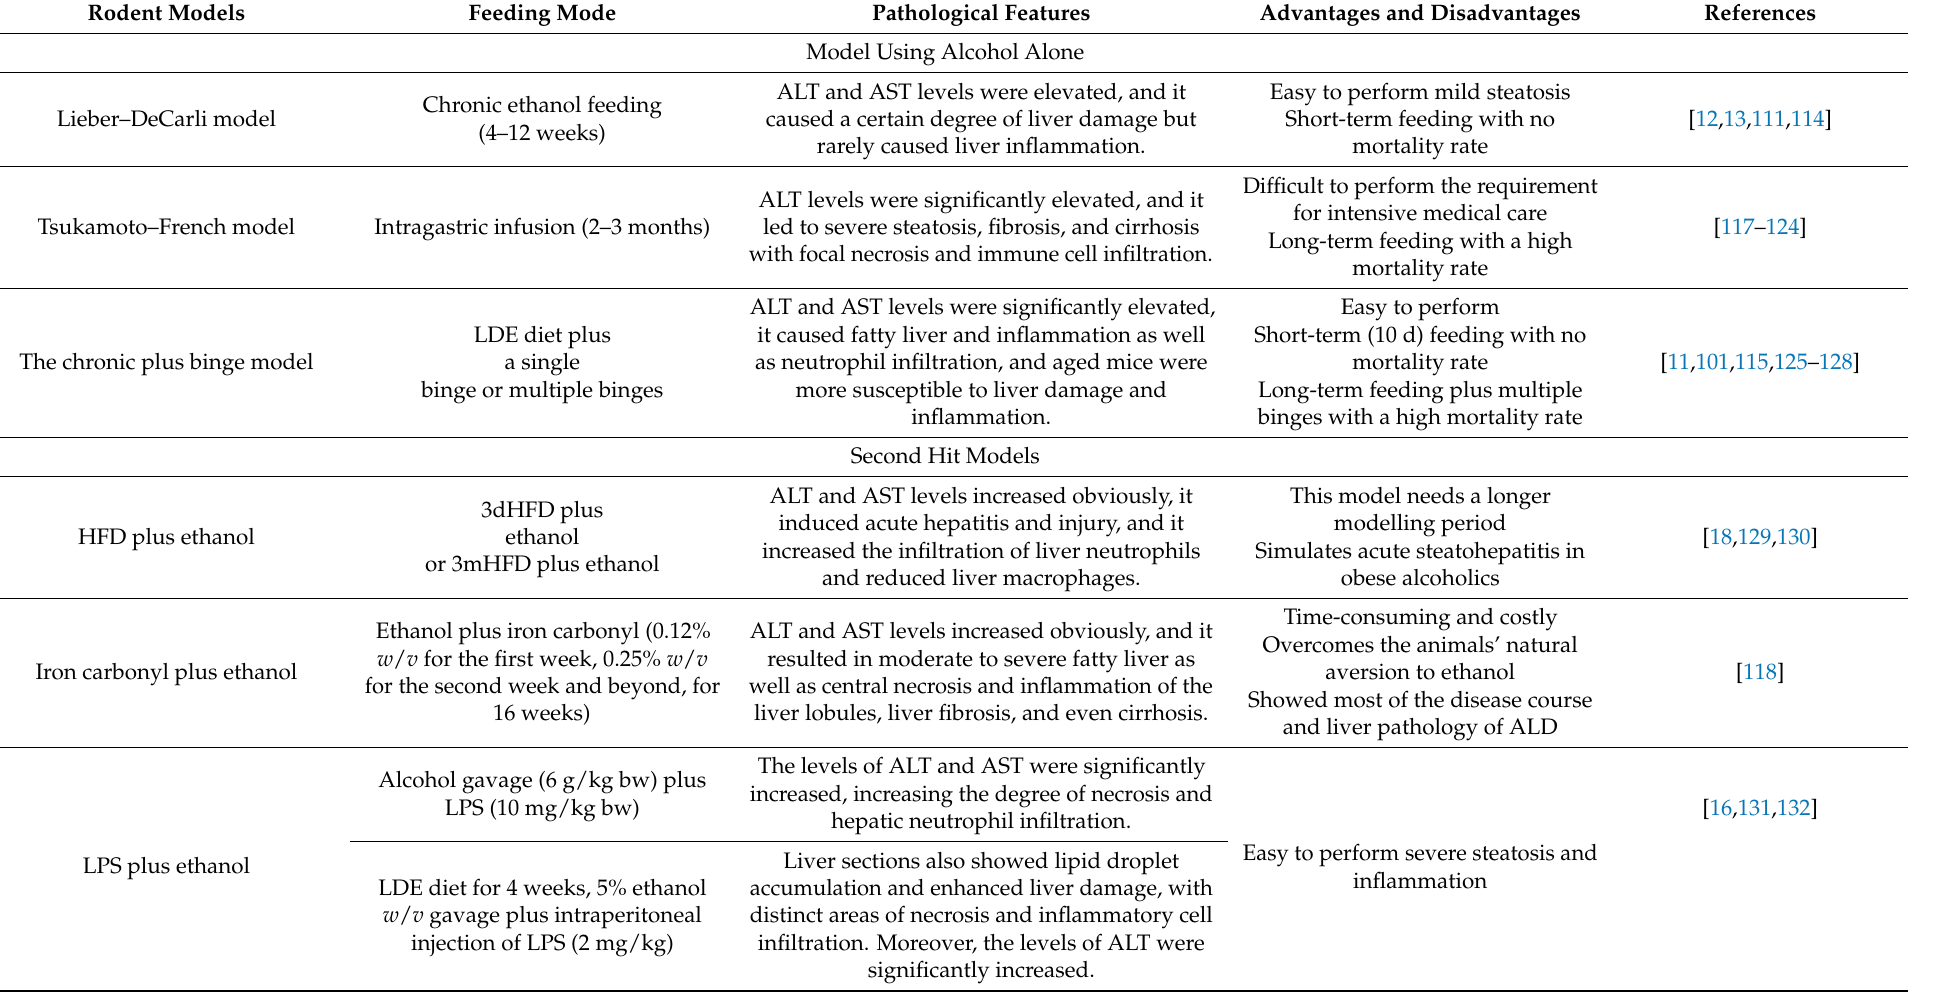
Table 1. Comparison of rodent models of alcohol-associated liver